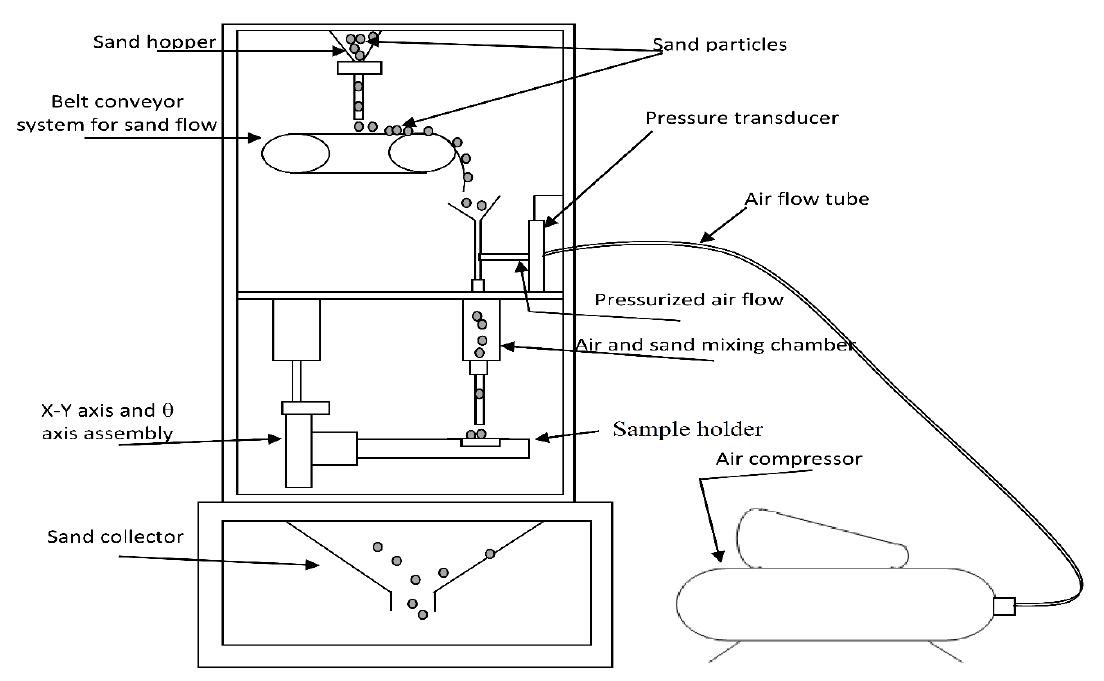
Figure 2. Schematic representation of solid particle erosion experimental